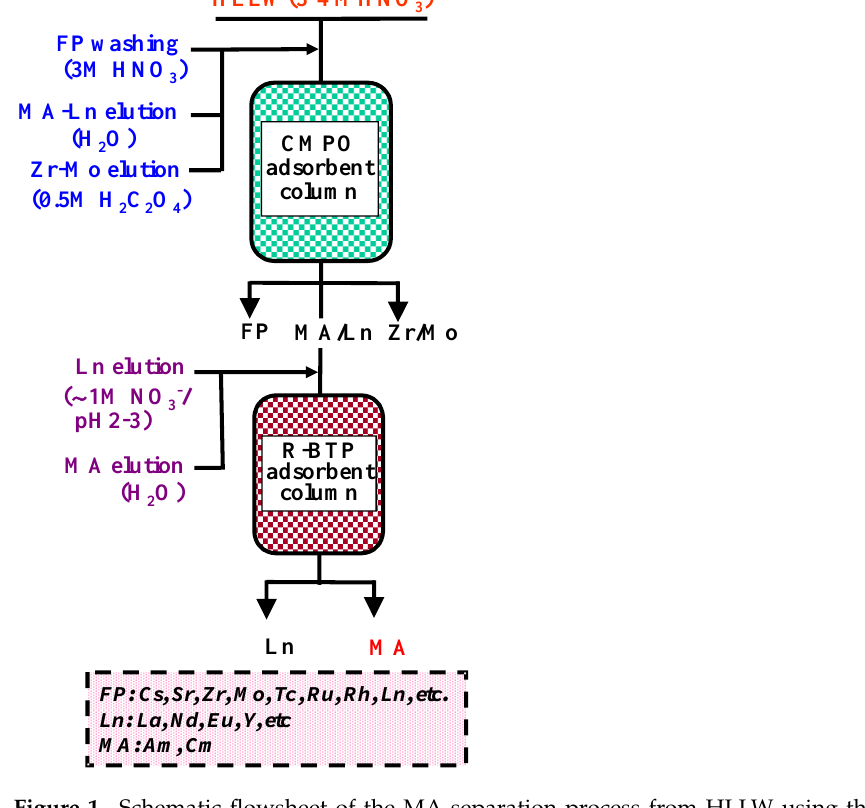
Figure 1. Schematic flowsheet of the MA separation process from HLLW using the adsorption method [11].